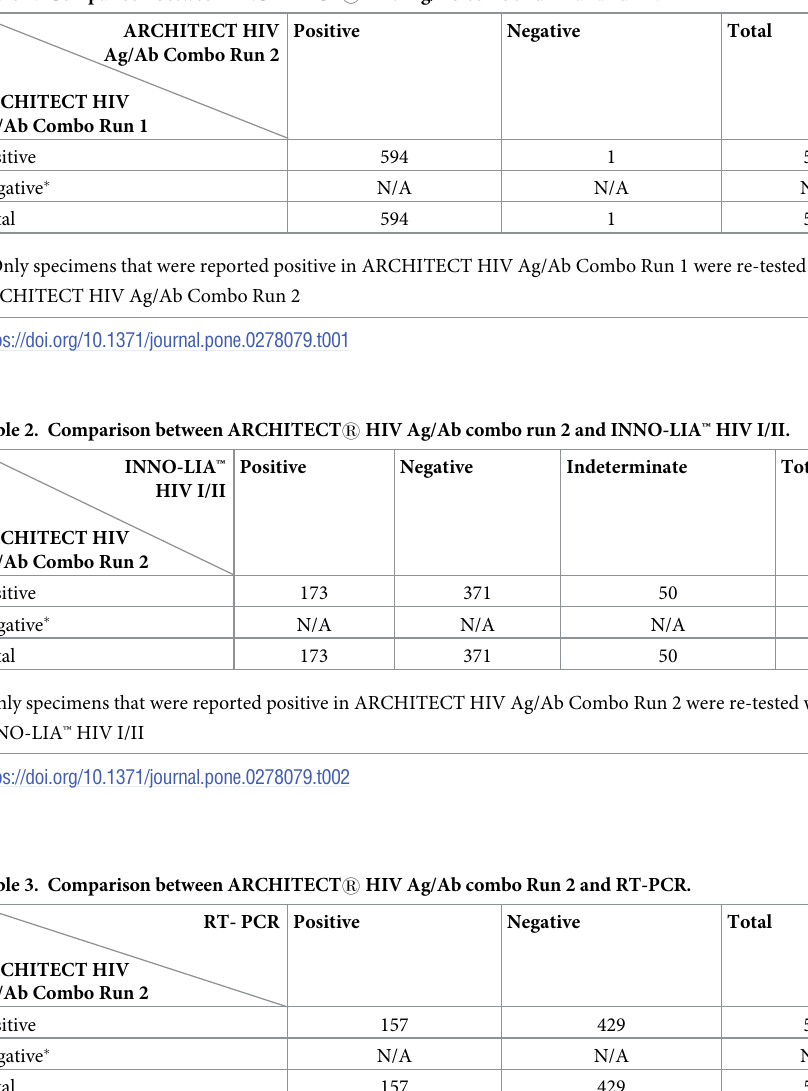
Table 1. Comparison between ARCHITECT 1 HIV Ag/Ab combo run 1 and run 2.